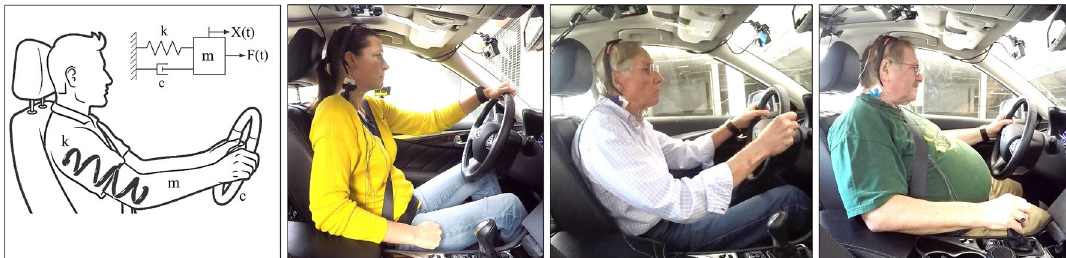
Figure 1. Individualized driver stress detection method using an unmodified car steering